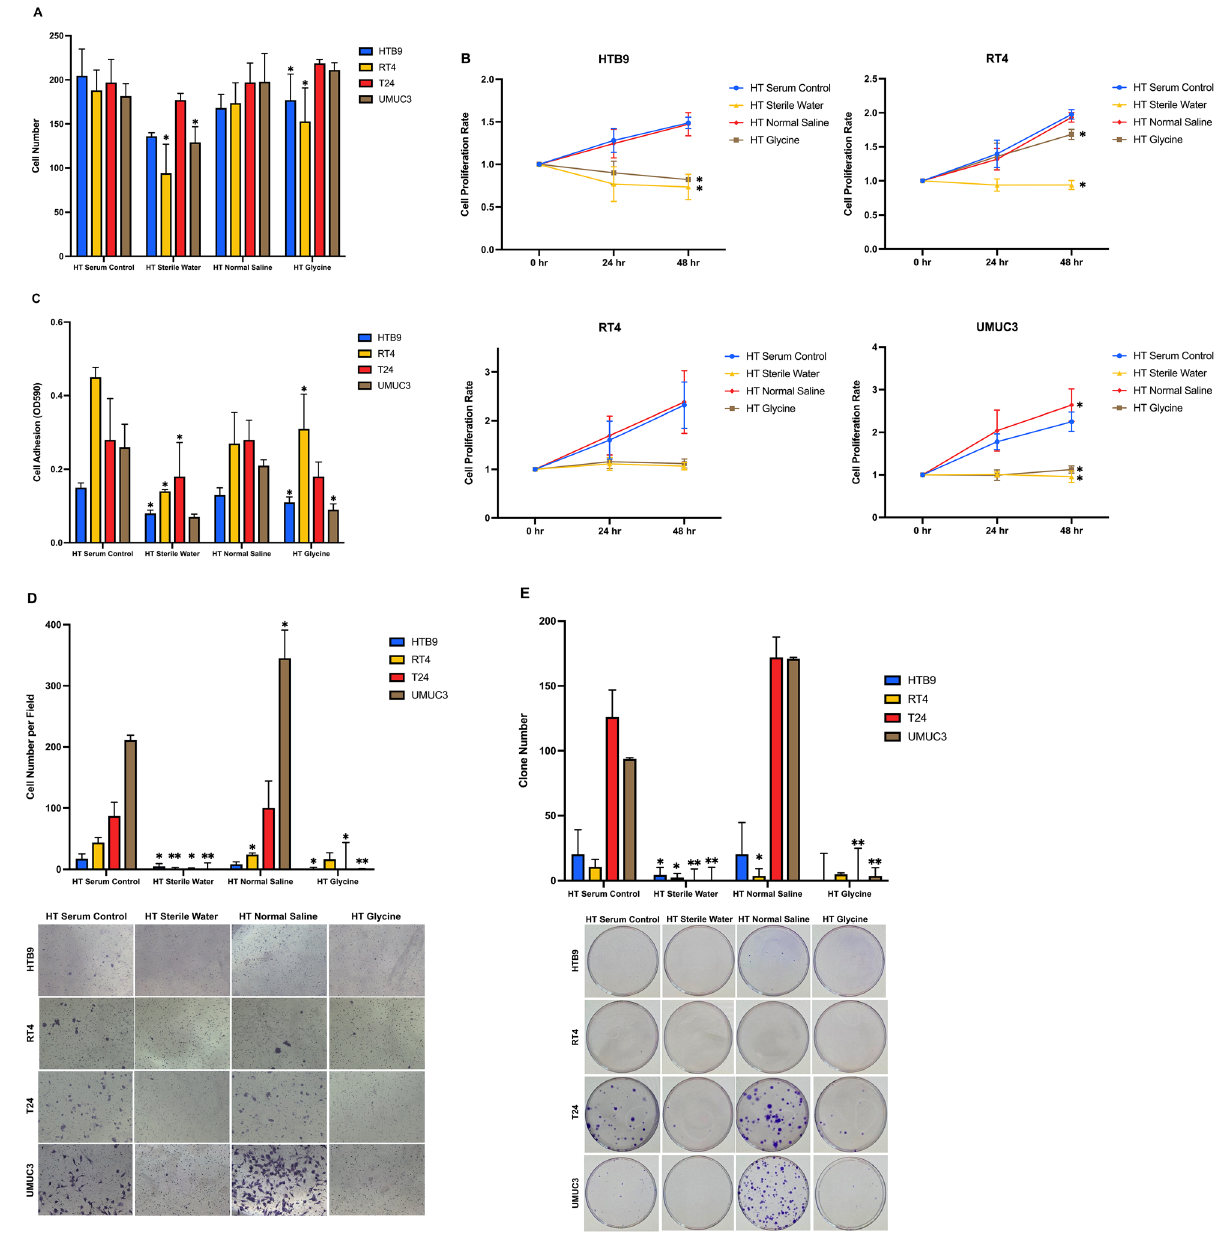
Figure 3. Cytotoxicity of combining hyperthermia and irrigation fluids. (A) HTB9, RT4, T24 and UMUC3 were incubated in sterile water, normal saline or glycine at 43 °C for one hour. Total cell counts were estimated by trypan blue exclusion assays. (B) Cell proliferation rates were measure by MTT assays and presented as relative fold change to 0 h. (C) Adhesion assay were evaluated by MTT assays as OD reading was proportional to number of adhered cells. (D) Invasion ability was evaluated by Matrigel gel transwell chambers. Cells with invasion ability were measured by crystal violet staining and cell counting. (E) Colonies formation ability was assayed by crystal violet staining and cell counting. Data are presented as mean ± SD. Different strategies were compared with serum control of the same cell line. *p < 0.05 and **p < 0.01, t test (n = 3, three independent biological replicates were performed for all the